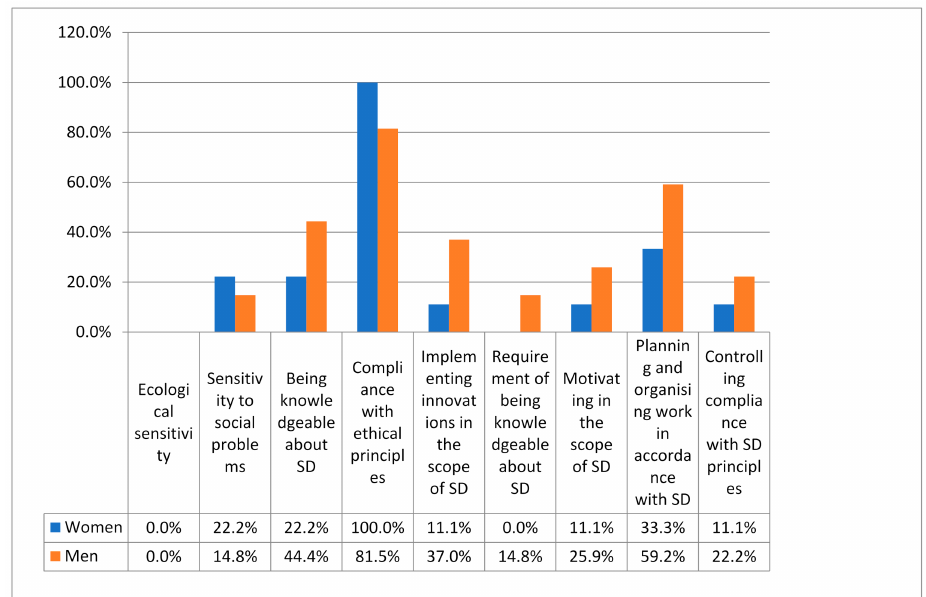
Figure 3. Energy companies’ managers in breakdown into men and women. Views about par- ticular traits and actions of a sustainable manager compliant with the model profile (scores of 5). SD—sustainable development. Source: own research.